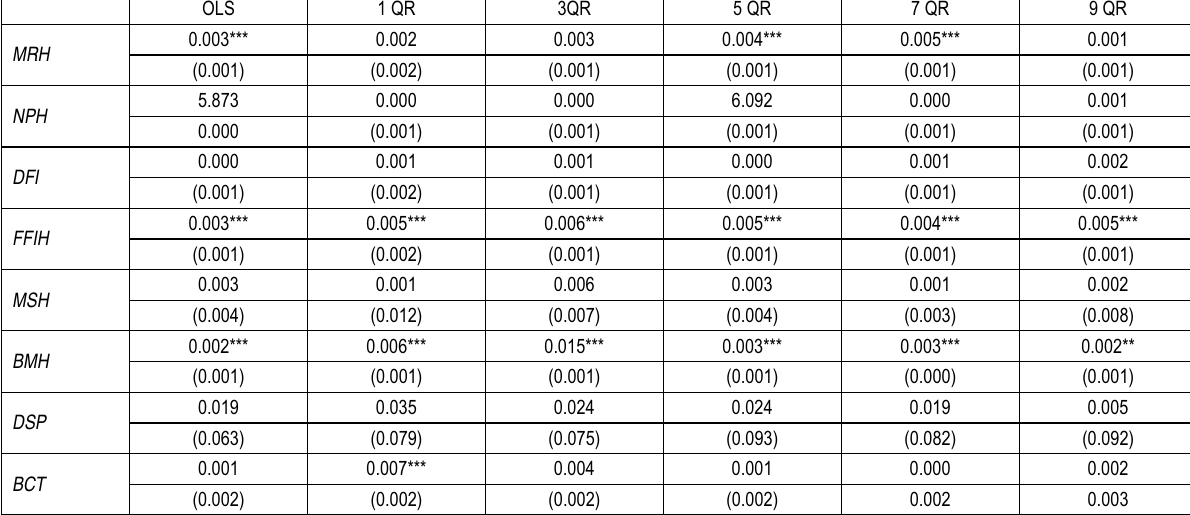
Table 4. The results of quantile regression on abnormal return ( AR